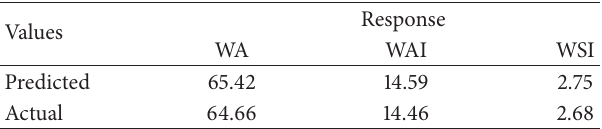
Table 4: Predicted response versus actual